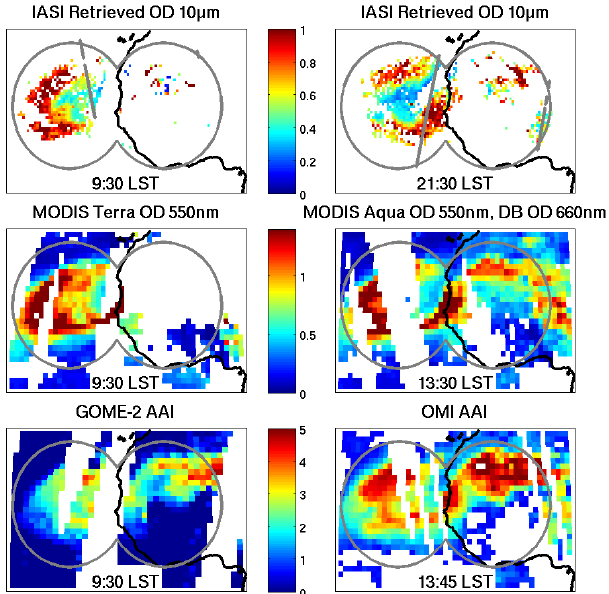
Fig. 9. Comparison, for a dust event on the 22 June 2009 above North Africa and off-shore, between the OD at 10µm retrieved from IASI TIR measurements (data was binned to a 0.5 ◦ × 0.5 ◦ latitude/longitude grid) and aerosol data from other satellite instru- ments. The thick grey lines represent the limits of the IASI data set treated in this work, and CALIOP measurement co-located with a IASI spectrum (maximum 100km, 6h). The approximate local solar time of the measurements is shown at the bottom of each